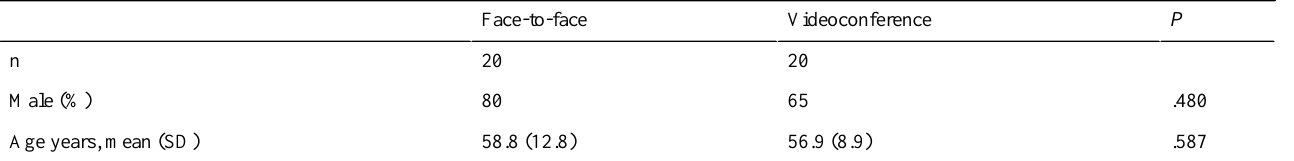
Table 3. Demographic characteristics of patients included in the RCT study (study 2; n=40).